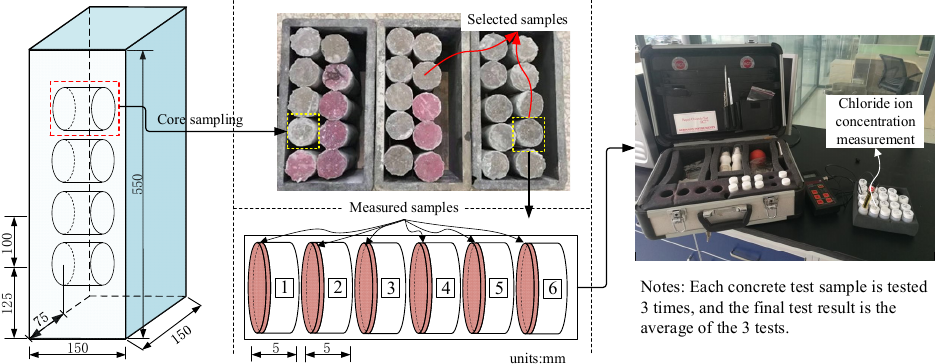
Figure 3. The chloride concentration measurement process.